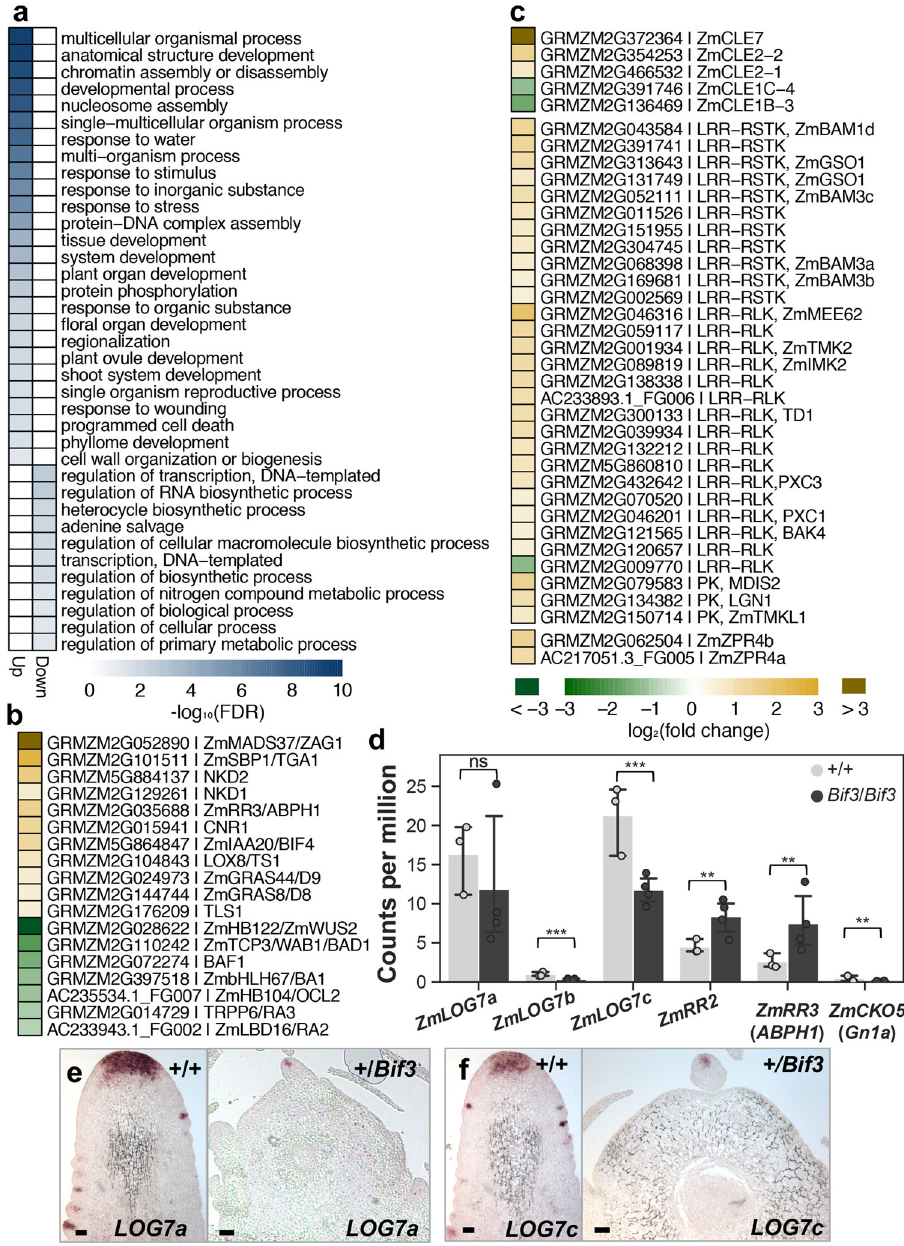
Fig. 5 Altered expression of key meristem genes in Bif3 ear primordia. a GO enrichment analysis of differentially expressed genes. b Differential expression of known developmental regulators. c Differential expression of CLAVATA3/ESR-related (CLE), protein kinase (PK), leucine-rich repeat (LRR)- receptor-like protein (LRR-RLP), LRR-receptor-like kinase (LRR-RLK), LRR-receptor-like serine/threonine-protein kinase-encoding genes (LRR-RSTK), and LITTLE ZIPPER4 (fold change ≥ 1.5). d Gene expression pro fi les. Two-tailed Student ’ s t -test ** p < 0.01; *** p < 0.001; ns, non-signi fi cant; plotted data represent mean ± standard deviation; n + / + = 3, n Bif3 / Bif3 = 4 (n pools of three ear samples). e , f RNA in situ hybridizations of ZmLOG7a and ZmLOG7c in Bif3 in fl orescence meristems. Bars: 200 µ